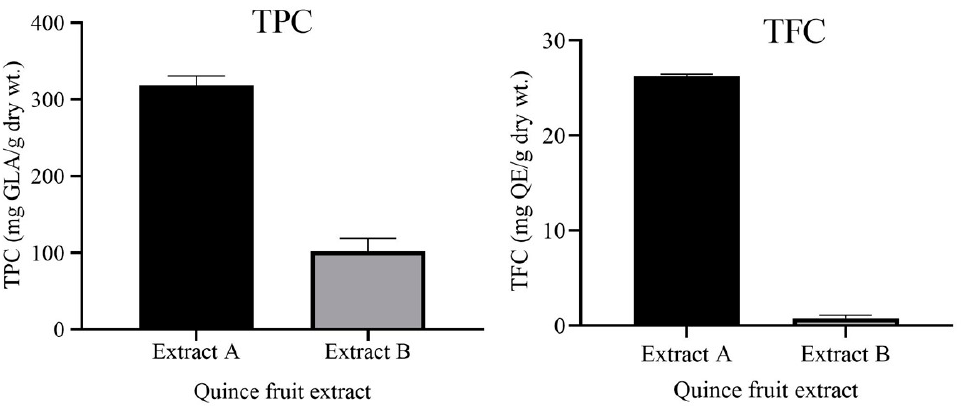
Figure 2. Total phenolic contents (TPC) and total flavonoid contents (TFC) of quince fruit extract. Purified extract (extract A), unpurified extract (extract